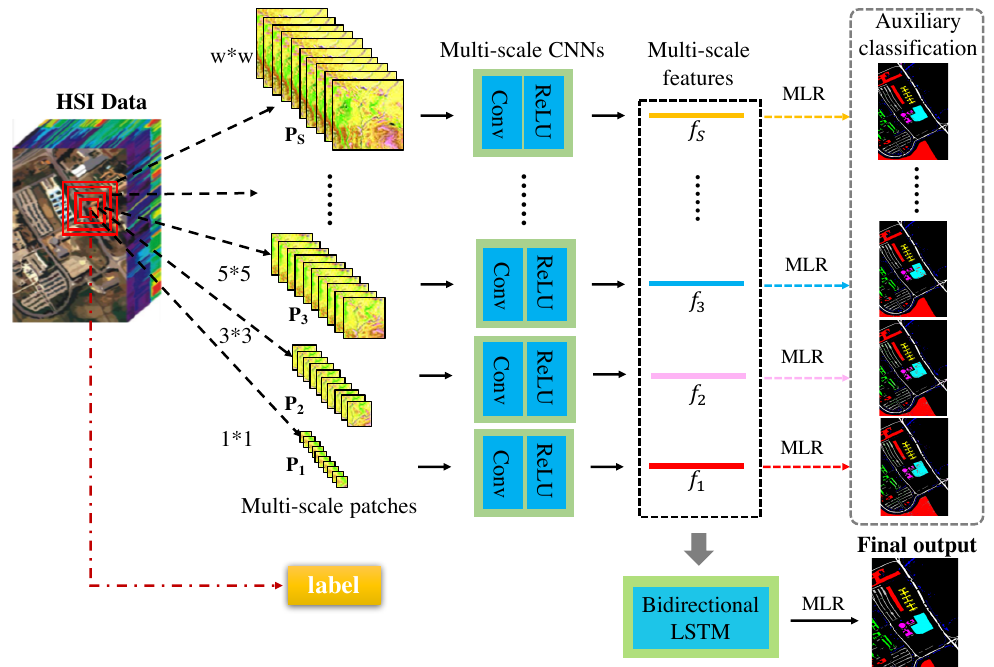
Figure 2. The architecture of the proposed HMCNN-AC consisting of multi-scale CNNs and a bidirectional LSTM. For each pixel in HSI, the generated multi-scale patches are sent to the multi-scale CNNs with auxiliary classifiers to extract multi-scale spectral–spatial features, then a bidirectional LSTM is employed to explore the scale-dependency of multi-scale features and output a hierarchical representation for the final supervised